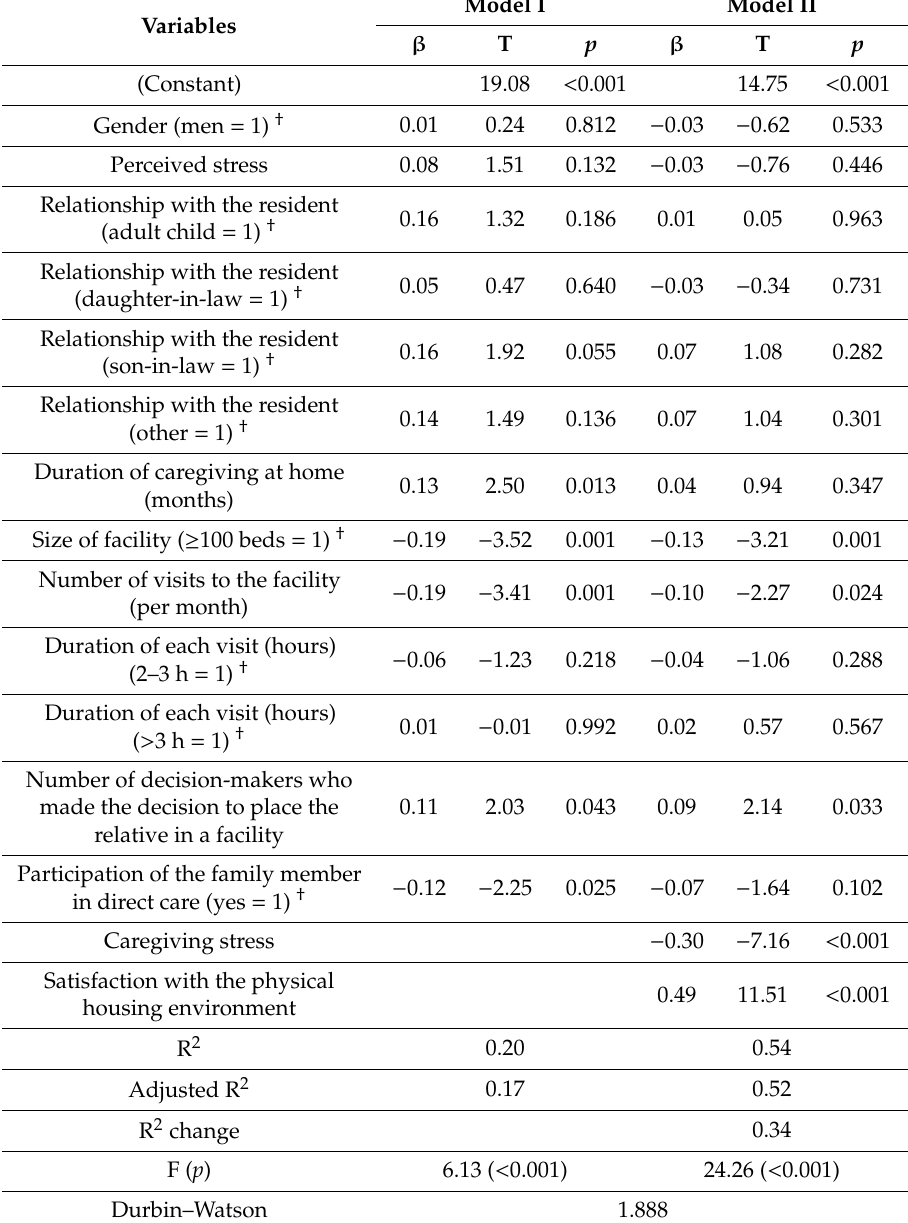
Table 7. Hierarchical multiple regression analysis with family caregivers’ satisfaction with care services in LTCFs, N =